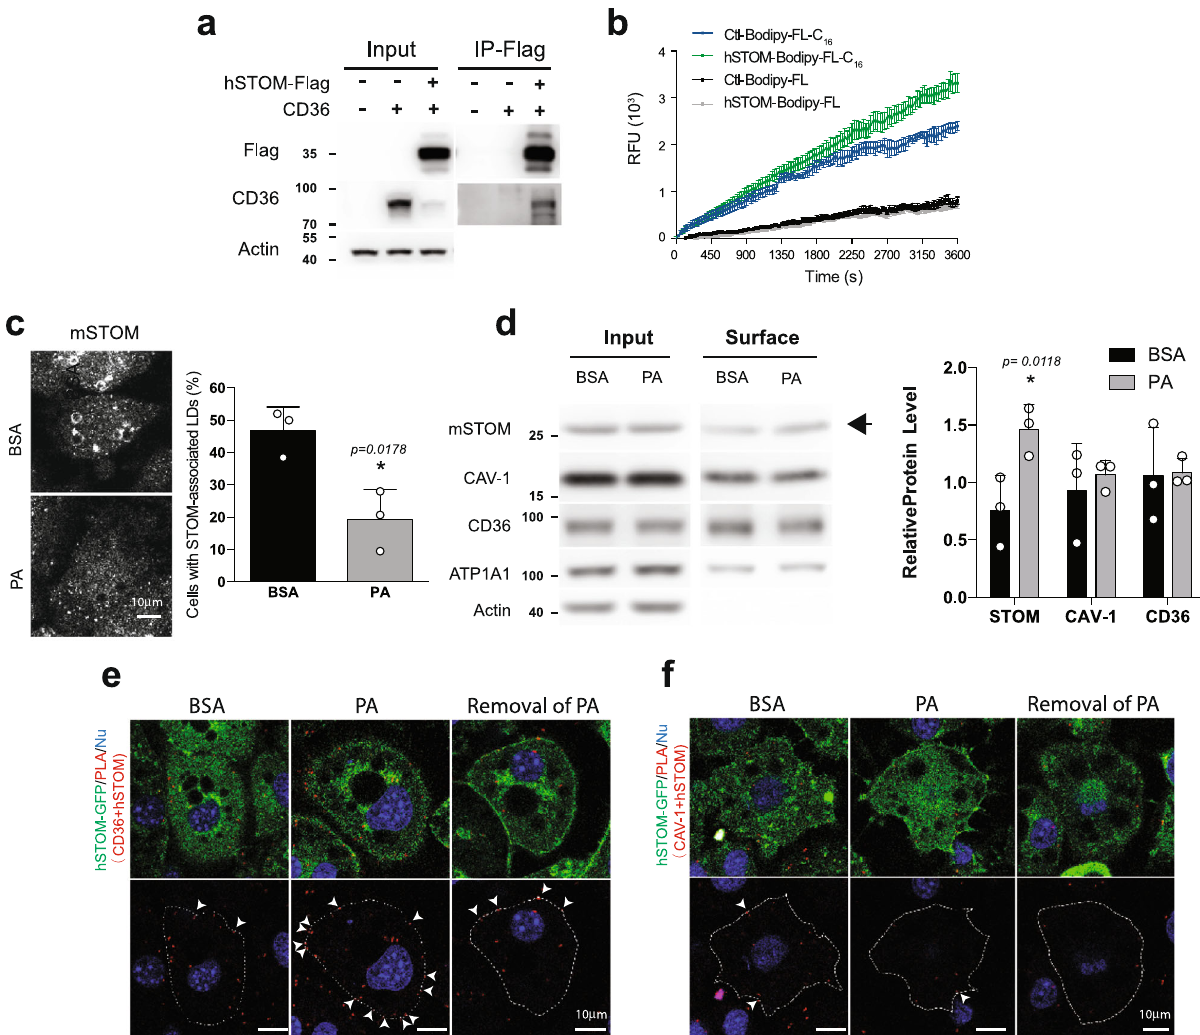
Fig. 3 Stomatin interacted with CD36 and facilitated fatty acid uptake. a Immunoprecipitation (IP) assays revealed molecular interactions between stomatin and CD 36 in vitro. b Fatty acid uptake assays were performed to measure internalization of lipid ingredients by adipocyte-like cells from the extracellular environment. Fluorescently-labeled fatty acid (Bodipy-FL-C 16 ) or fl uorescent tag alone (Bodipy-FL) was added to the culture medium of adipocyte-like cells expressing exogenous stomatin (hSTOM), or control vector (Ctl). The degrees of Bodipy-FL-C 16 and Bodipy-FL internalization were measured by intracellular accumulations of fl uorescence over time. Mean± s.e.m. for at n = 3 for Bodipy-FL-C 16 n = 6 for Bodipy-FL uptake independent cells. c Immuno fl uorescence staining demonstrated that in cells treated with BSA, about half of the cell population contained stomatin-associated LDs. Treating cells with palmitic acid (PA) resulted in dissociation of STOM from LDs. Mean ± s.d. for three independent experiments. * P < 0.05 by two-sided unpaired t -test. Bar = 10 µ m. d Surface biotinylation followed by Western blotting analyses of the biotinylated proteins were performed to quantify the surface portion (Surface) of a membrane protein, including stomatin, CD36, caveolin-1 (CAV1), or ATP1A1, relative to the total amount of individual proteins (Input). Actin proteins could not be labeled by surface biotinylation method and therefore contained no surface portion. Note increase of surface portion of stomatin after PA treatments (arrow) compared to the BSA control. In contrast, the surface portion of CD36, CAV1 remained unchanged after PA treatments. Mean ±s.d. for three independent experiments. * P < 0.05 by two-way ANOVA analysis. e , f Proximity ligation assays (PLA) were performed in 3T3-L1 adipocyte-like cells over-expressing exogenous human stomatin fused with GFP (hSTOM-GFP). Duolink ® PLA reactions occurred when PLA probes for CD36 e or for CAV1 f were in closed proximity with hSTOM-GFP. Addition of connector oligos joined the PLA probes, resulting in in situ proximity ligation and formation of amplicon (arrowheads). e PA treatments promoted interactions between CD36 and stomatin on the plasma membrane, as evidence by the increased amplicons along cell surface compared with the control BSA treatments; removal of PA reversed such an increase. On the other hand, f PA treatments did not affect interactions between calveolin-1 and stomatin. Bar = 10 µ m. Source data are provided as a Source data fi Depleted STOM blocks the adipogenesis and LD enlargement . intraperitoneal glucose tolerance test (IPTGG) was more intol- erable in HFD-fed STOM Tg than the control mice. Obesity is often associated with ectopic fat accumulation in the liver. Indeed, HFD-fed STOM Tg mice exhibited larger liver mass (hepatomegaly), and macro- and microvesicular steatosis. These phenotypes were related to impaired liver functions, as evidenced by elevated serum levels of GPT and GOP (Fig. 5d). stomatin expressions. Knockdown of stomatin was noted to inhibit